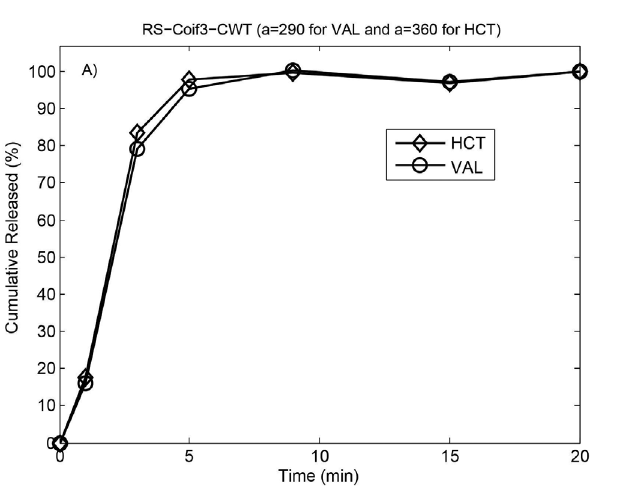
FIGURE 7A - Dissolution profiles of VAL and HCT obtained by applying RS-coif3-CWT method.